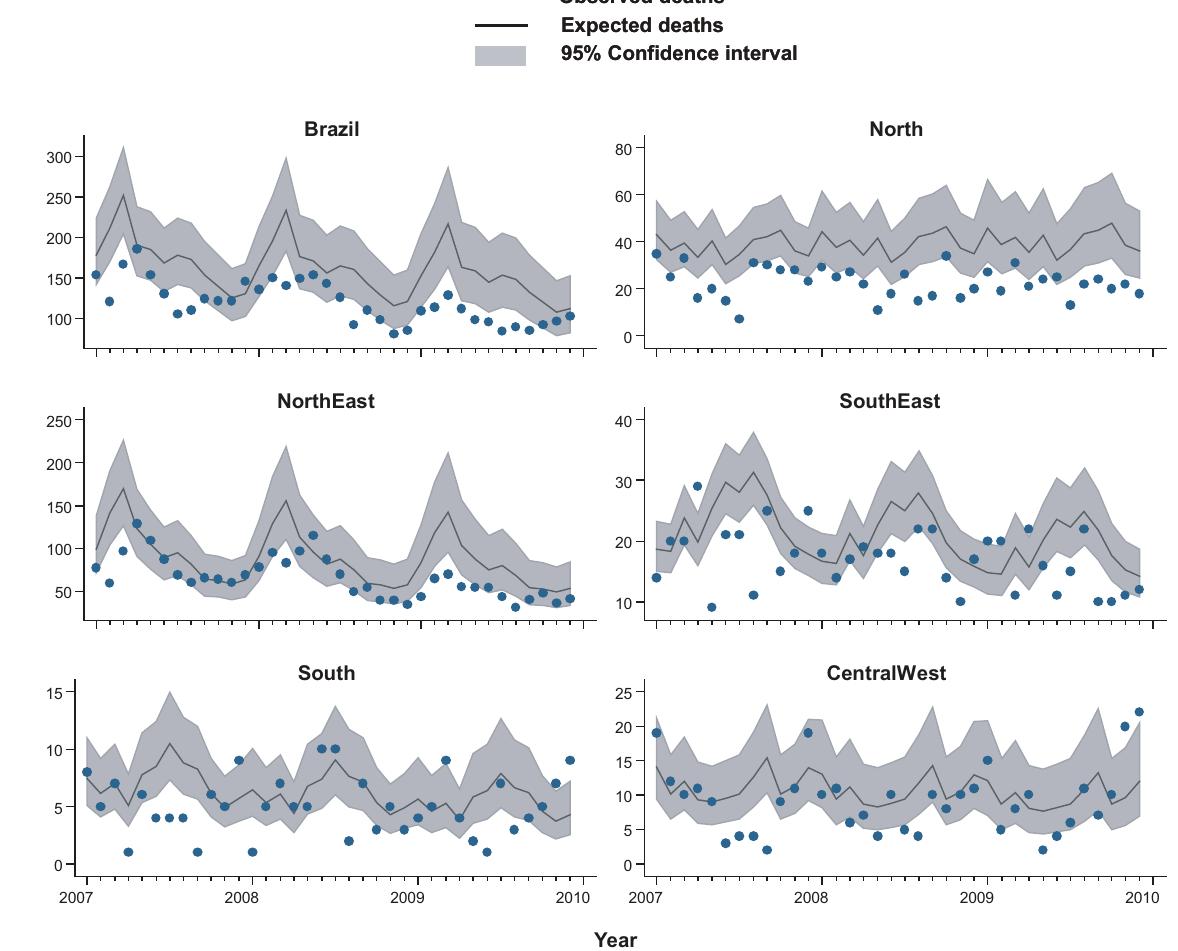
Figure 2. Impact of rotavirus vaccination on monthly events of childhood diarrhea deaths in Brazil by region. Each analysis compares the monthly observed events among children under 5 y after rotavirus vaccination (2007 to 2009) with expected events in the absence of vaccination, by region. Expected number of events and 95% CIs are based on predictions from regression models fitted to historic data from each region (2002 to 2005).